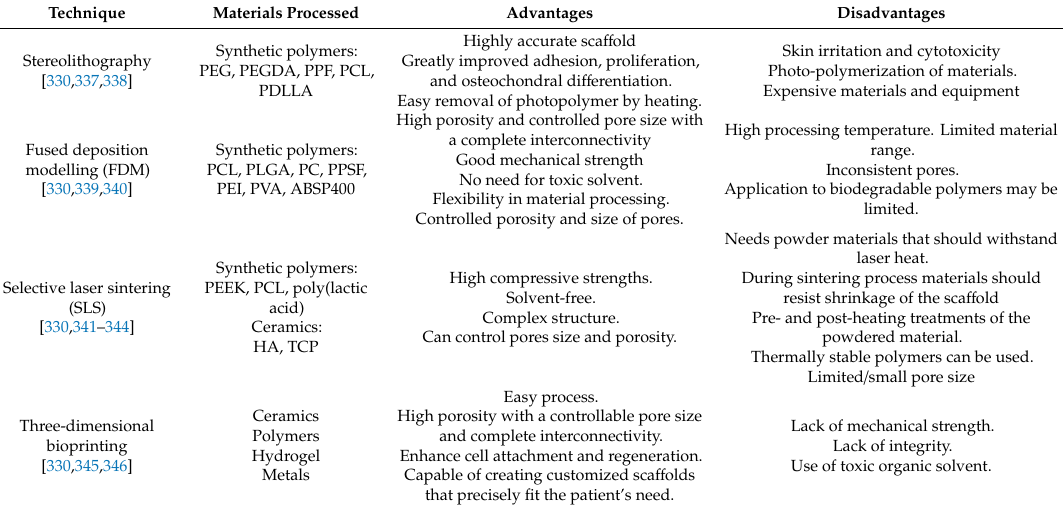
Table 7. Summary of the materials processed, advantages and disadvantages of rapid prototyping techniques for biomimetic sca ff old